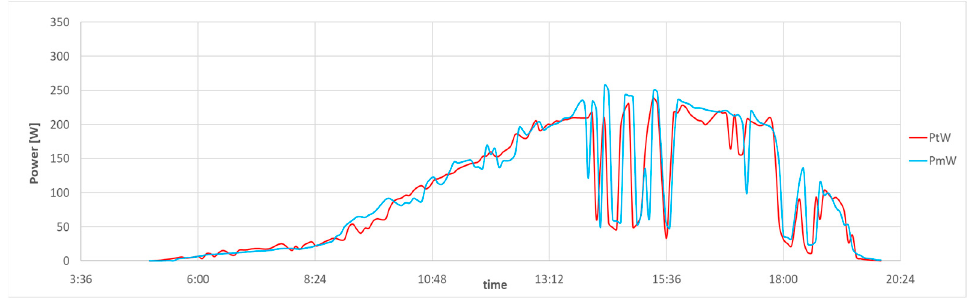
Figure A3. Comparison of simulated and measured power waveforms for PV cells oriented westward, bearing 290°; PtE—theoretical power, PmE—measured power. An analysis of the figures indicates that simulated power waveforms significantly differ for the same meteorological data. The causes behind the differences are solely the values of calculated direct radiation, which provides considerably varying values after conversion for individual azimuths. It can also be seen that simulated and measured power waveforms for individual azimuths are very similar. Particularly noteworthy is the consistency of the waveforms during intensive insolation changes (14 ÷ 16 h). The obtained results prove the high accuracy in calculating direct and diffuse radiation; hence, the developed function covering the dependence of diffuse radiation on total radiation is accurate. Similar studies were also conducted for photovoltaic systems at three different locations based on meteorological station data and inverter capacity waveforms. The results also confirmed high accuracy of the simulation model.